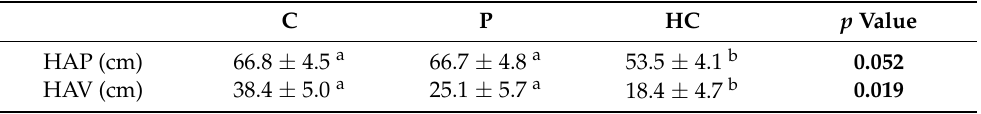
Table 5. Mean ( ± SEM) distance from stationary human (HAP) and the distance the chicken moved away from the approaching human (HAV) when chickens that were raised under standard conditions (Control); with additional physical items (P); or with additional human contact (HC). Differing superscript within a column indicates treatment differences at p < 0.05. Bold font indicates significant p -values at p < 0.05.